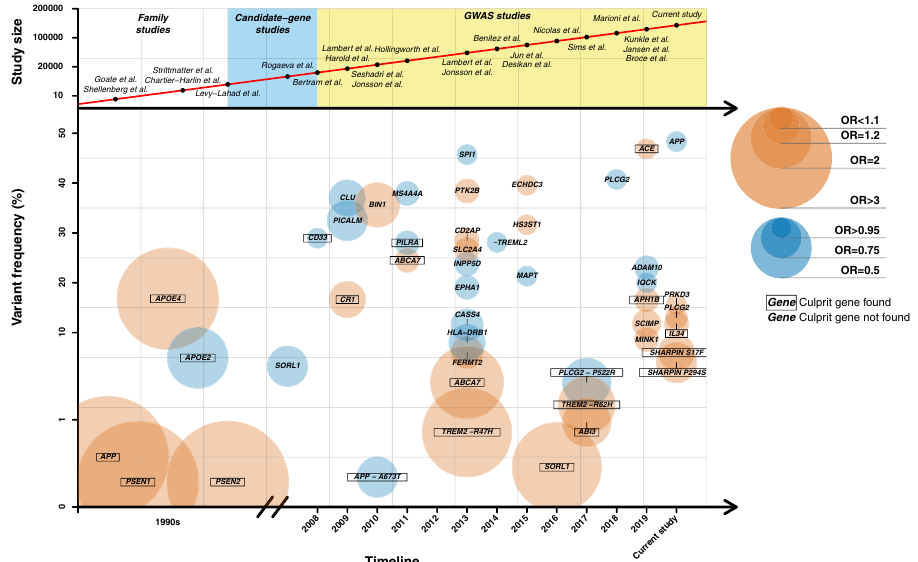
Fig. 3 Genetic landscape for Alzheimer ’ s disease. This fi gure shows the history of genetic discoveries in AD research over the past 30 years. This fi gure was constructed to our best knowledge of literature, but is not a systematic review of literature. For common variants, we selected only signals fi rmly replicated in large meta-GWAS (Lambert et al. 3 , Kunkle et al. 20 , Jun et al. 43 , Sims et al. 7 , Jansen et al. 38 and present study). For rare variants, we only selected those variants widely replicated excluding those loci presenting con fl icting results. Abbreviations and more information about the genes can be found in Supplementary Data 4. The risk alleles associated with AD were represented in orange and the protective alleles in blue. GWAS Genome-Wide Association Study, OR odds